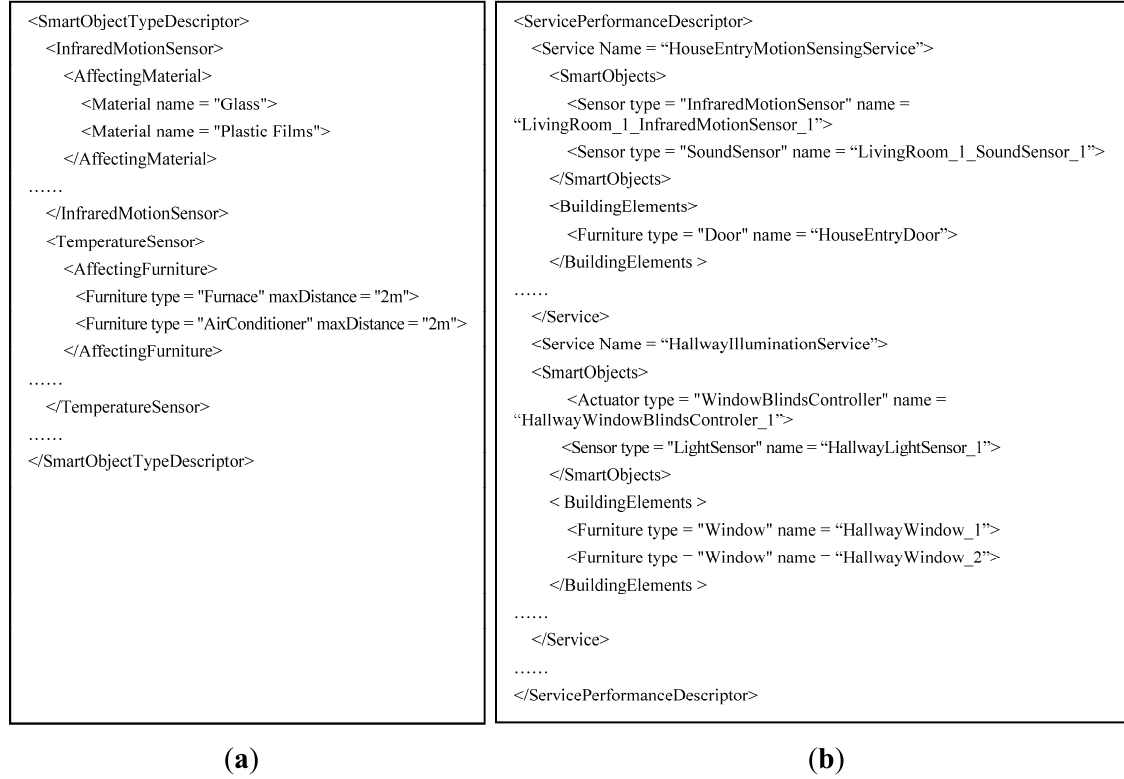
Figure 6. ( a ) Example of a smart object type descriptor; ( b ) Example of a service performance